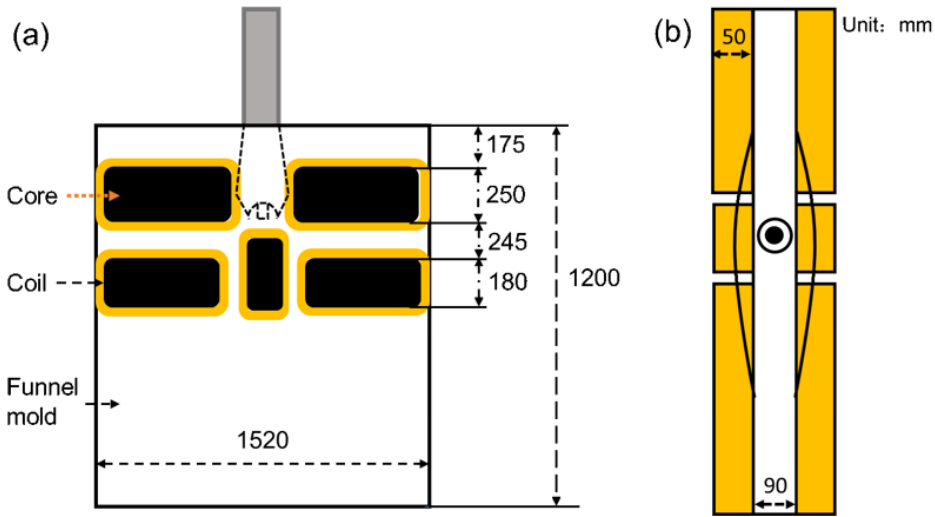
Figure 2. Two-dimensional model size diagram of FTSC funnel mold with EBMr device. ( a ) Front view and ( b ) top view.